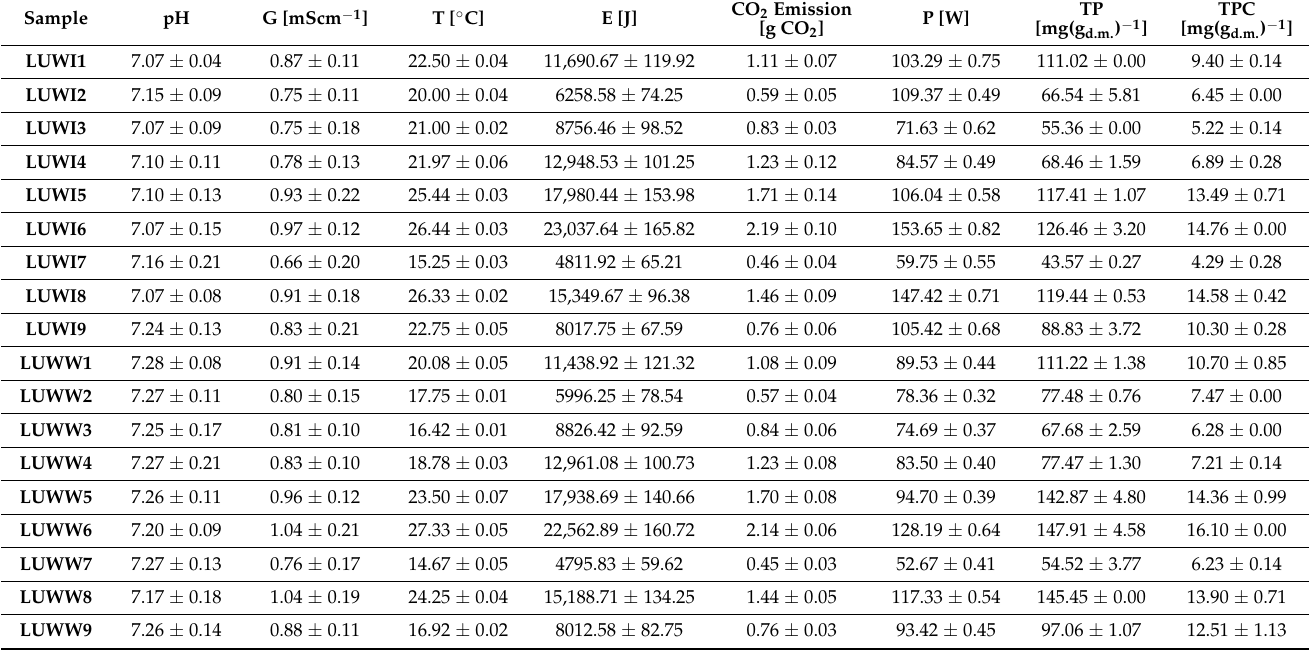
Table 4. Results of pH value, temperature, electrical conductivity, energy, CO 2 emission, power, total protein, and total phenols content for LUWI and LUWW